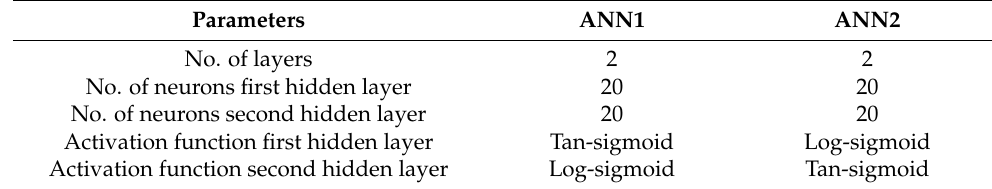
Table 6. Detailed information about the developed artificial neural network (ANN)